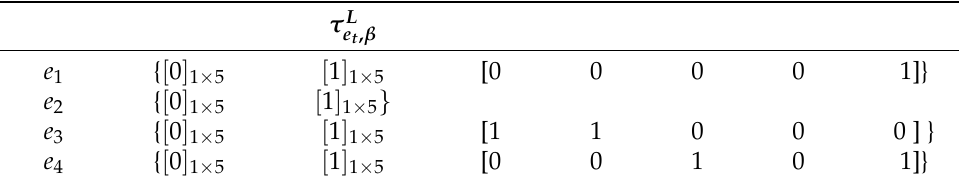
Table 5. β -Lower- e t topology; β = [ β 1 , β 2 ] , t = 1, . . . ,4.